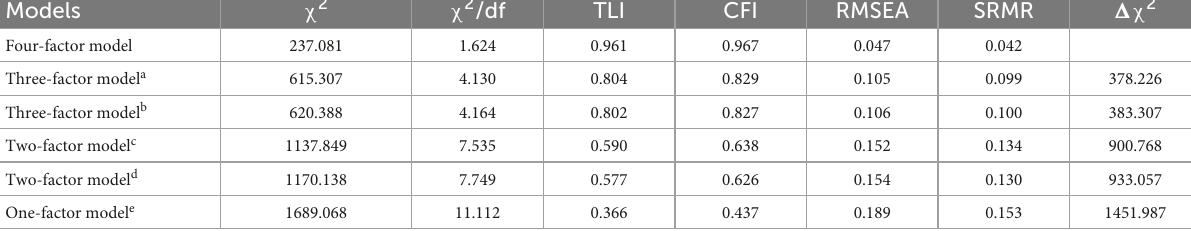
TABLE 2 Confirmatory factory analysis results.